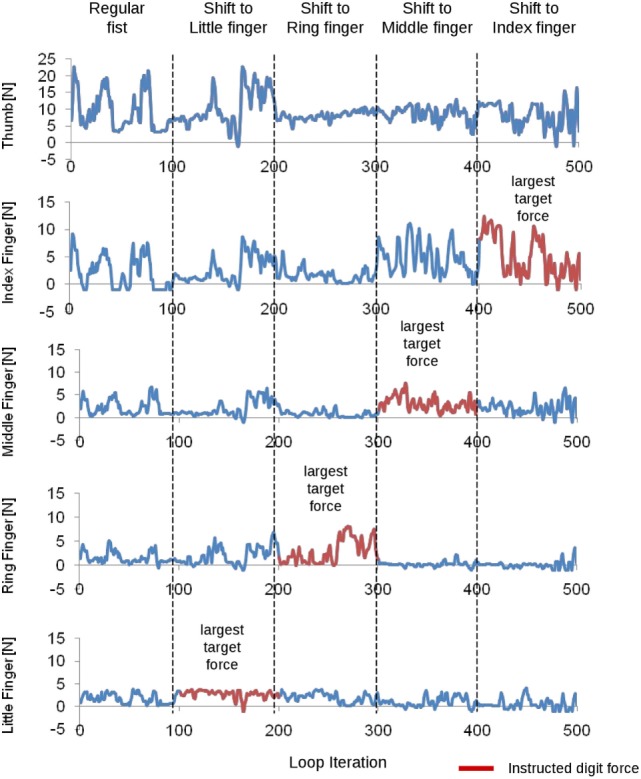
Electromyographic decoder output for each finger flexion force (one subject). The subject was instructed to vary the force distribution across the fingers. The instruction given to the subject is shown on top for each time epoch. Time epochs are separated by vertical dashed lines. Data from each digit are shown on each row. The instructed digit for each task is denoted by a red trace. The little finger is expected to show an increased predicted force during loop iteration 100–200. During loop iteration 200–300, the ring finger is expected to show an increased predicted force. During loop iteration 300–400, the middle finger is expected to show an increased predicted force. During loop iteration 400–500, the index finger is expected to show an increased predicted force.